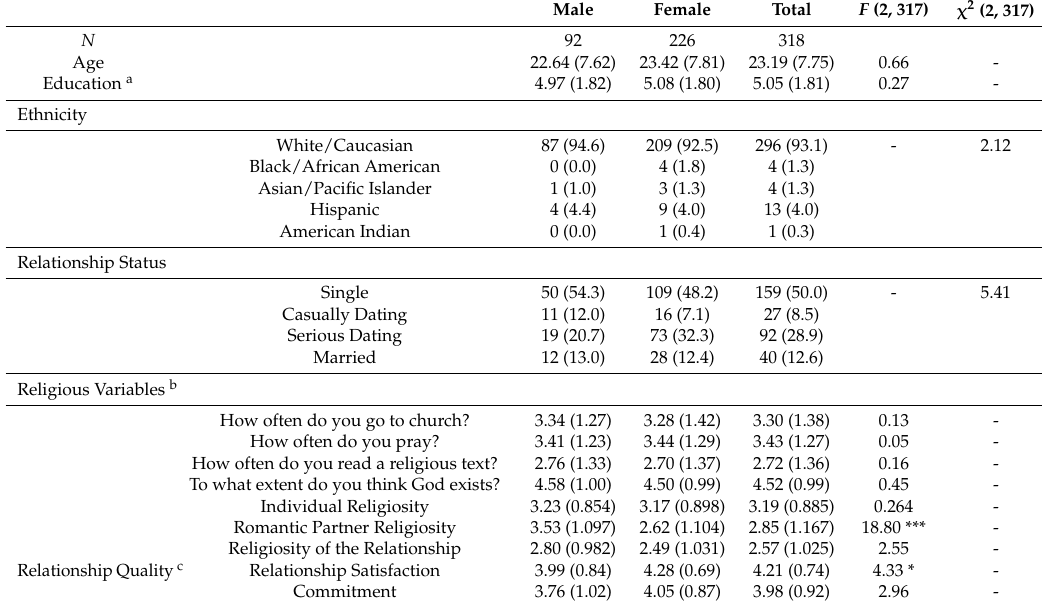
Table 1. Descriptive statistics for entire sample ( N =